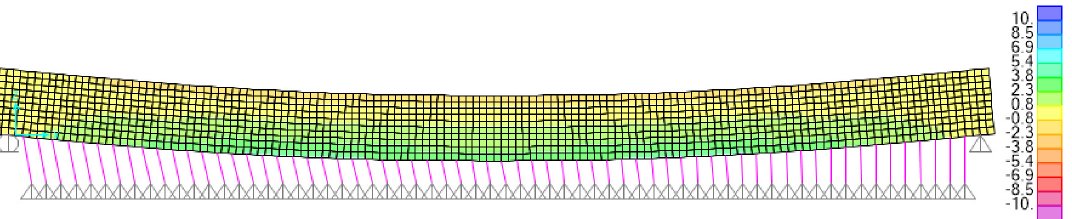
Figure 31. Tensile stress distribution for 10 mm-settlement scenario.